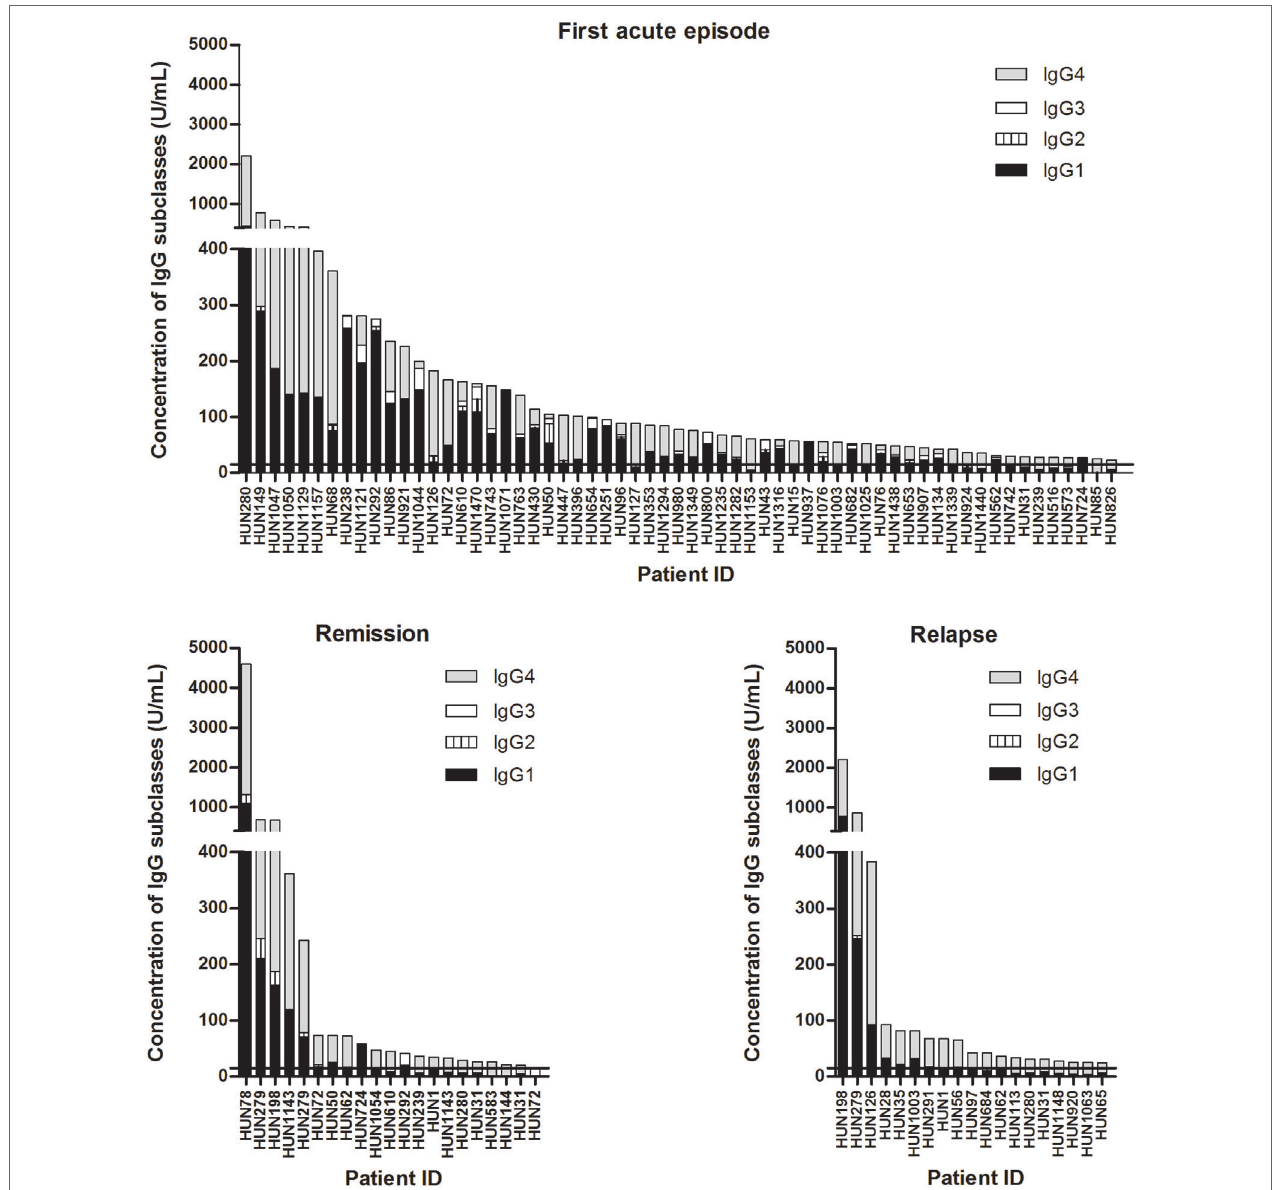
FigUre 3 | Concentration and subclass distribution of anti-ADAMTS13 IgG autoantibodies in the first acute phase, in relapse, and in remission. The horizontal line marks the cutoff value (15